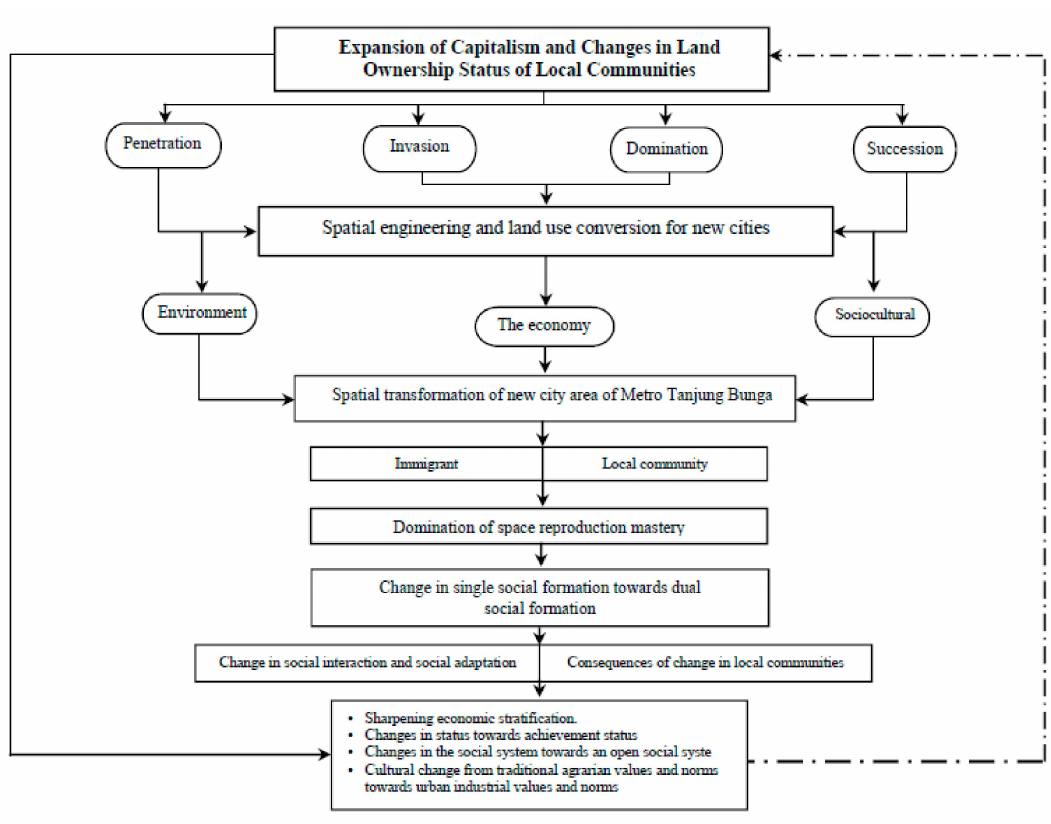
Figure 16. The process of social change in the local communities in the new city area of Metro Tanjung Bunga. Source: Author